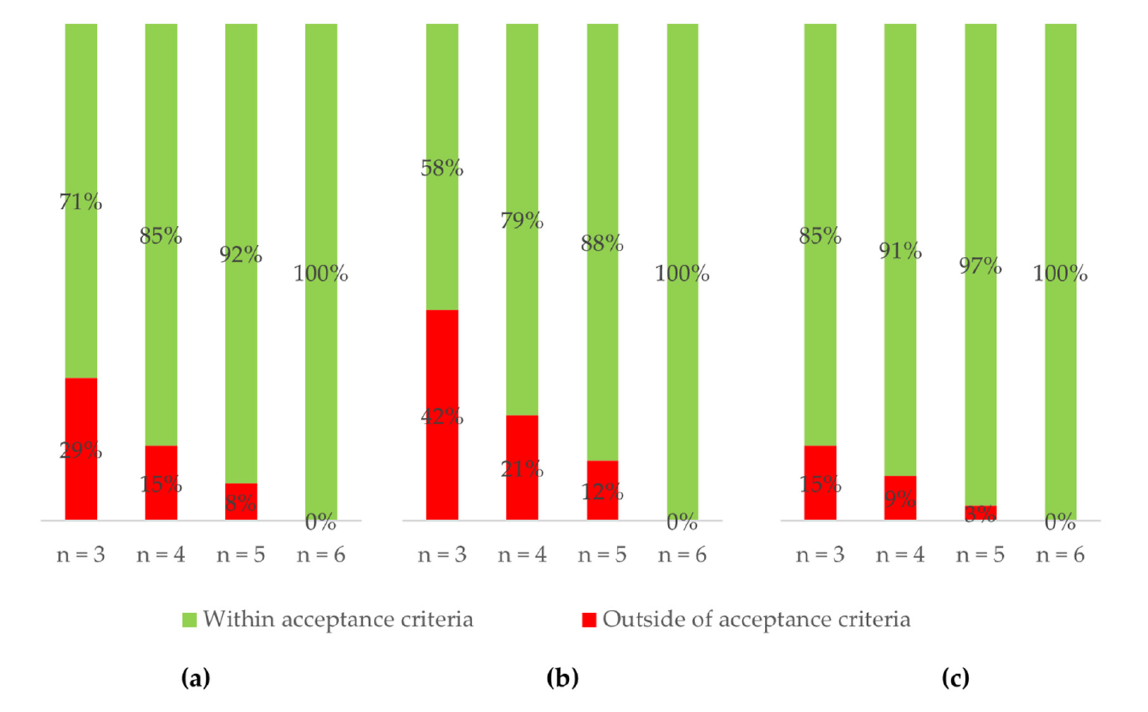
Figure A2. Retrospective study: Percentage of confidence intervals outside (red) and within (green) stability acceptance criteria for ( a ) all data, ( b ) low QC concertation, and ( c ) high QC concertation. Combined data from a retrospective study of nine drugs using n = 3, 4, 5, and 6.